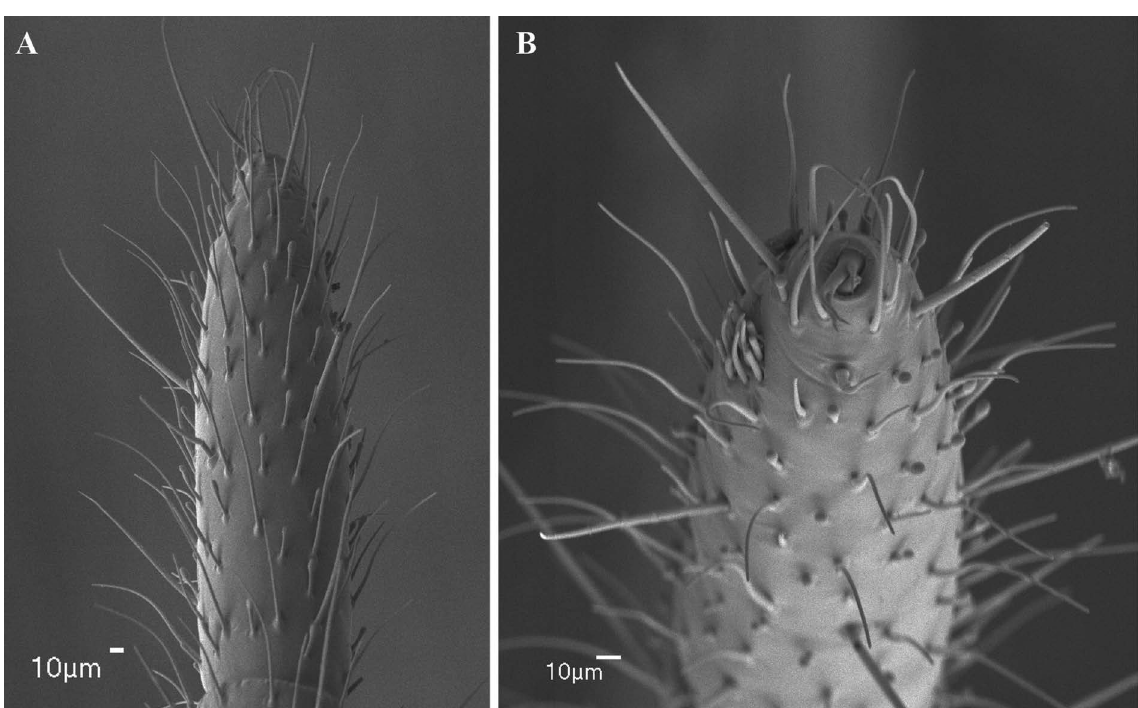
Fig. 153. Weygoldtia consonensis sp. nov. (AMNH), antenniform leg I, ♂. A . Apex of leg, lateral view. B . Modified claw, rod sensilla and tarsal